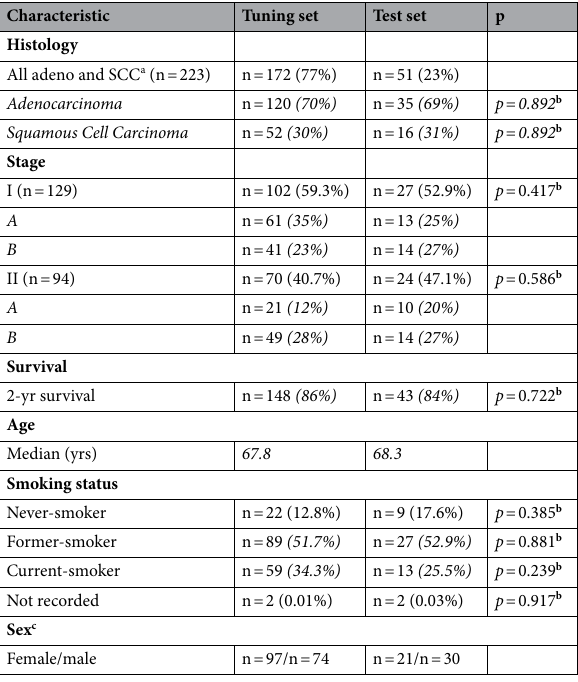
Slicer software (version 4.5.0–1, https ://www.slice r.org/), after assessment of transverse sections slice by slice. We then extract 3D volumes around the seed-points and from this, 2D input tiles measuring 50 mm × 50 mm (Figure S1 in Supplementary Material). Isotropic rescaling was performed on the image data with a linear interpolator to minimize distortion, applying scaling factors that allow for a uniform spatial representation of 1 mm × 1 mm for each isotropic pixel. Density normalization was also performed with mean subtraction and linear transformation. Classification with deep convolutional neural-networks. In this exploratory analysis, CNNs were used for feature extraction and image classification. To address the challenge presented by the scarcity of curated medical data as well as the heterogeneous CT data normally encountered in routine clinical practice, we used a transfer learning approach. Here, robust models that are effective at performing other computer vision tasks are fine-tuned to perform visual recognition on our imaging data. The VGG-16 (Visual Geometry Group) neural network architecture 29 pre-trained on a large natural image dataset (ImageNet) was assessed. We evaluated the network with fine-tuning of the last convolutional, pooling, and fully connected layers. Hyperparameter optimi- zation was explored iteratively. Inputs of the VGG-16 model were 50 mm x 50 mm image patches. The model had three input channels, all of which were fed grayscale images (that is, model inputs are identical stacked images). Fine-tuning was performed over 100 epochs with a subset of patients that had either ADC or SCC histology for our primary model, model A , and with a mix of all 3 histology types (ADC, SCC, and "Other") for the second- ary model, model B (Fig. 2). Accordingly, the final prediction (softmax) layer was set to 2 for model A, and 3 for model B (Fig. 3). The predictive performance of the models was evaluated with the area under the receiver opera- tor curve (AUC), and other performance metrics outlined in the model assessment section.